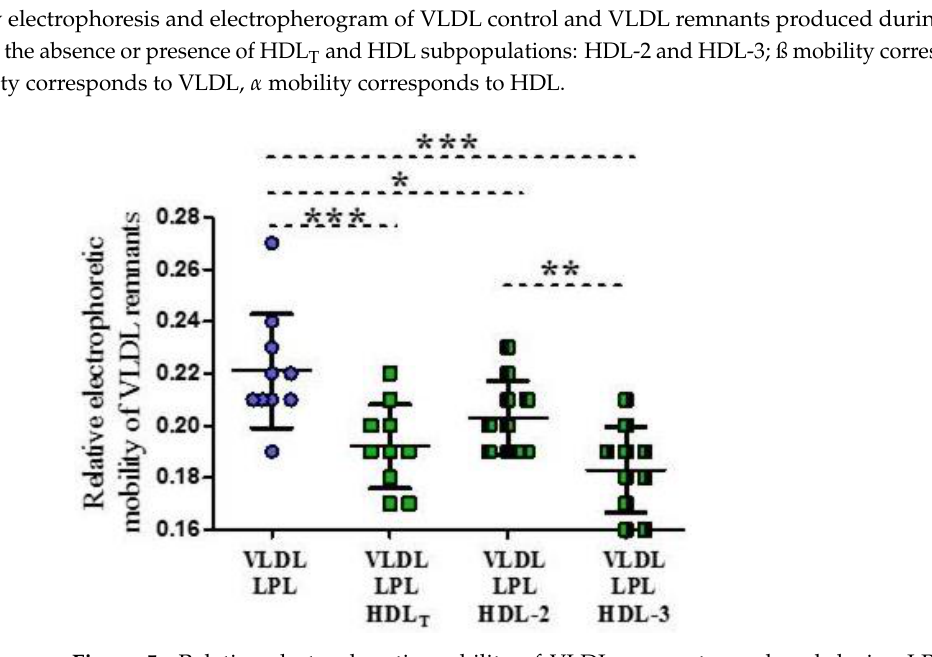
Figure 5. Relative electrophoretic mobility of VLDL remnants produced during LPL-mediated li-